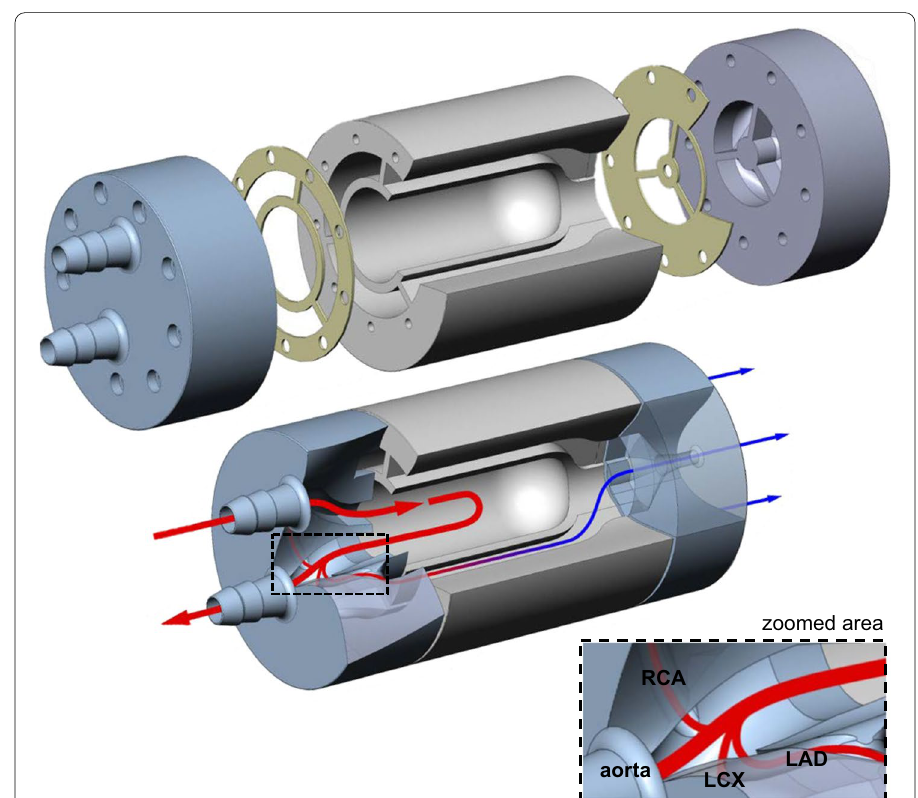
Fig. 1 Exploded view (top) of phantom design and tailored cross section (bottom) to illustrate inner phantom connections. The arrows indicate flow direction and magnitude, and its color differentiates between arterial input (red) and venous output (blue). The middle phantom part comprises of the simulated left ventricular cavity and three surrounding myocardial segments. The two outer parts contain the in- and outlet connections to the flow circuit and the internal branches to the segments. These branches correspond to the main coronary arteries, i.e., the left anterior descending coronary artery (LAD), right coronary artery (RCA) and left circumflex coronary artery (LCX). The phantom parts are fastened together with nylon screws whereby silicone seals are placed in between the parts for